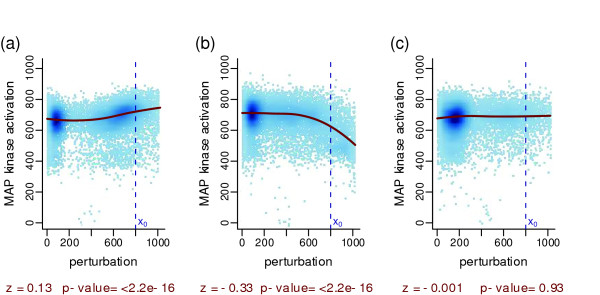
Example results for continuous responses from a MAPK screen. Effect size z and P value for (a) an activator (PLCD4), (b) a repressor (DUSP10), and (c) a non-affector (YFP) of the MAPK signaling. DUSP, dual specificity protein phosphatase; MAPK, mitogen-activated protein kinase; PLCD4, phospholipase C δ4; YFP, yellow fluorescent protein.